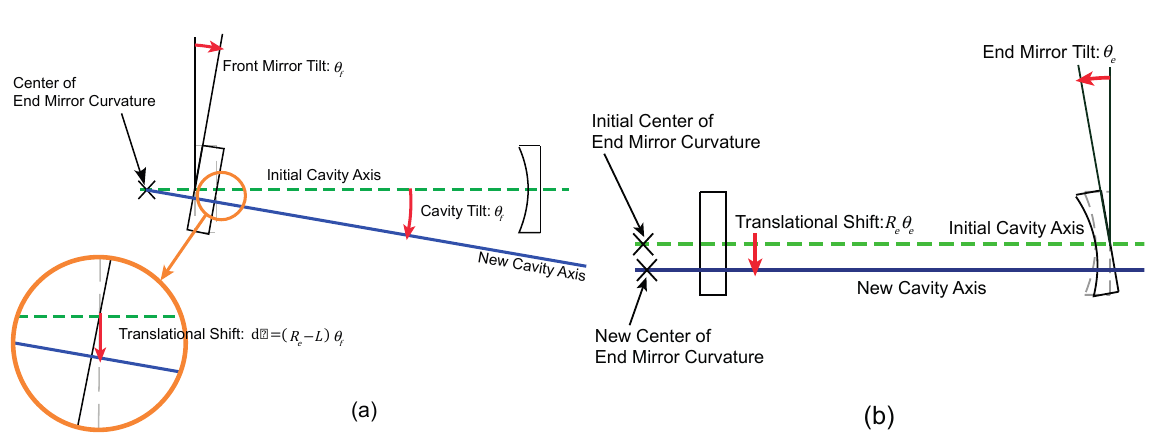
Figure 3. Geometric effect caused by the cavity mirror tilt. The tilt of the flat front mirror induces the cavity axis to tilt and shift sideways simultaneously ( a ), while the end mirror tilt causes only a perpendicular shift, because of its concave shape ( b